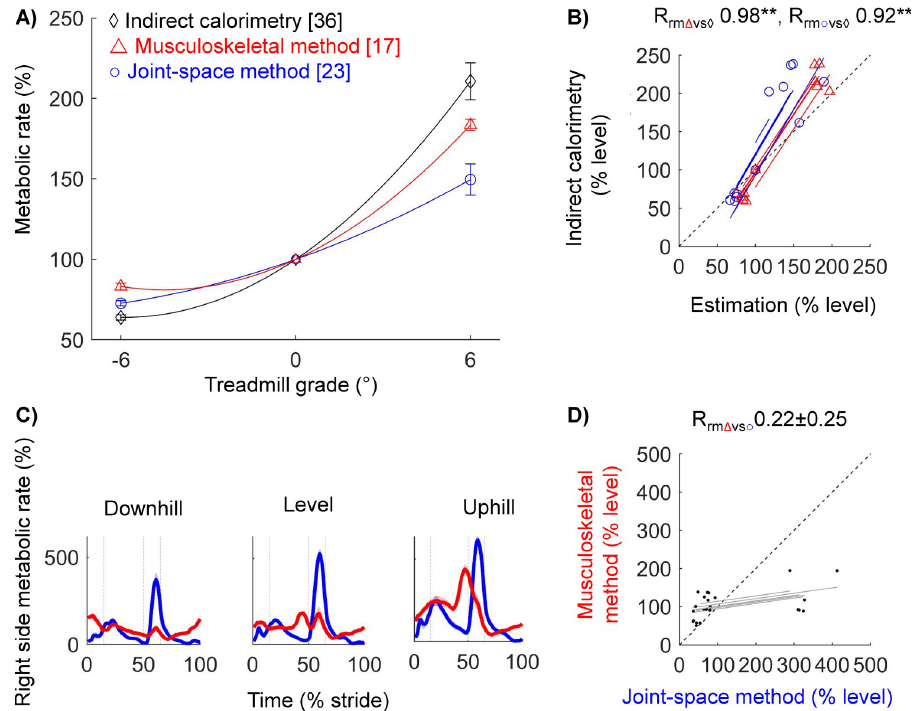
Fig 6. Estimations of the stride average metabolic rate and the time profile of metabolic rate during downhill, level, and uphill walking with level shoes. (a) Stride average metabolic rate. Red triangles, blue circles, and black diamonds indicate the results from the musculoskeletal estimation, the joint-space estimation method, and indirect calorimetry, respectively. Error bars indicate s.e.m. The average trends across conditions from the same method are shown as a solid line from a second-order polynomial curve fit. (b) Individual stride averages. Symbols are individual trials. Lines are individual fits from the repeated measures correlation test. Slopes that are less or more steep than a slope of 1/1 indicate overestimation or underestimation, respectively. R rm -values indicate the repeated measures correlation. �� indicate that the P-value of the repeated measures correlation is � 0.01. (c) Time profiles under different treadmill conditions. Red and blue lines indicate the results from the musculoskeletal estimation and joint- space estimation methods, respectively. Strides are segmented from the ipsilateral heel strike to the next ipsilateral heel strike. The shaded area indicates s.e.m. (d) Individual phase averages. Symbols are averages of the phases during the level walking condition separated by vertical lines: first double support (from ipsilateral heel strike to contralateral toe- off), single support, second double support (from contralateral heel strike to ipsilateral toe-off), and swing phase. R rm - values indicate mean ± s.e.m. of the repeated measures correlations of the different walking